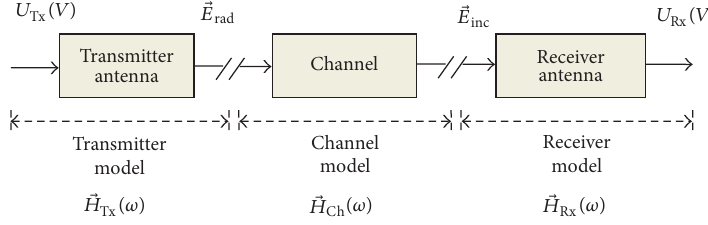
Figure 7: UWB system channel model.